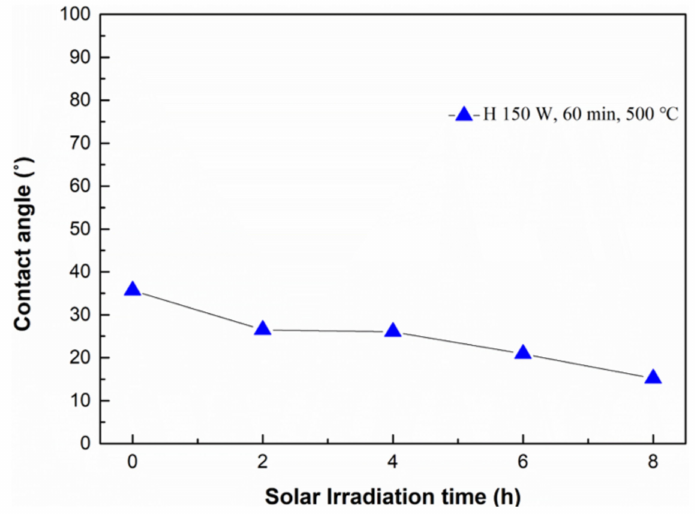
Figure 12. Variation in water contact angle with solar irradiation